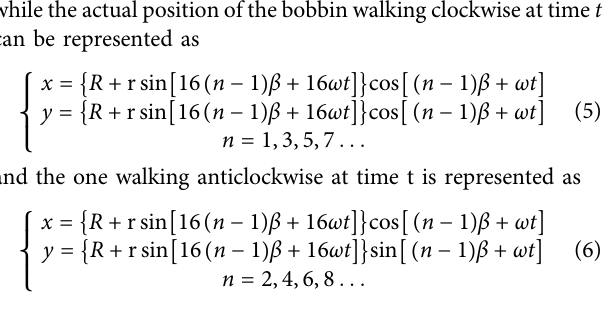
Frontiers in Materials |